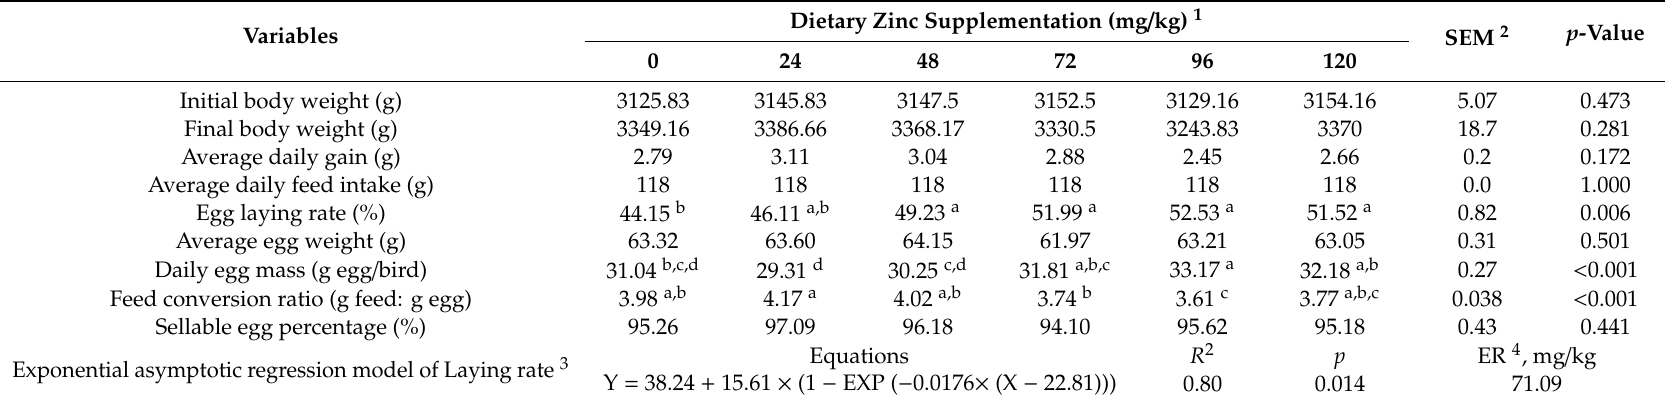
Table 2. E ff ects of dietary zinc supplementation on productive performance of Chinese yellow-feathered broilers breeders aged 58 to 65 weeks.